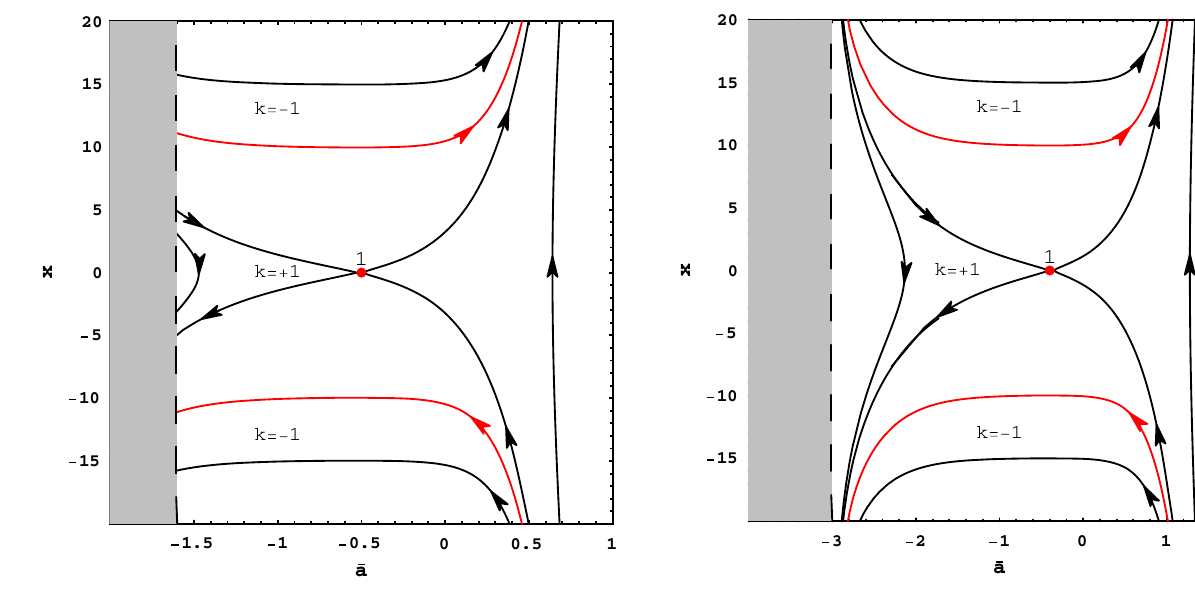
Fig. 12 The phase portrait for system (15)–(16) in the Einstein frame Fig. 11 The phase portrait for system (15)–(16) in the Einstein frame in the case when the evolution of the universe starts from the freeze inthecasewhentheevolutionoftheuniversestartsfromthegeneralized singularity. For illustration it is assumed that f ( ˆ R ) = ˆ R + γ ˆ R 2 + δ ˆ R 3 , suddensingularity.Forillustrationitisassumedthat f ( ˆ R ) = ˆ R + γ ˆ R 2 + (cid:3) (cid:4) (cid:3) (cid:4) (cid:3) (cid:4) (cid:3) (cid:4) s 2 Mpc 2 s 4 Mpc 4 s 2 Mpc 2 s 4 Mpc 4 δ ˆ R 3 , where γ = 10 − 9 where γ = − 10 − 9 and δ = − 10 − 13 .Criticalpoint and δ = 10 − 13 . Critical km 2 km 4 km 2 km 4 (1) represents the static Einstein universe and is a saddle. The black point (1) represents the static Einstein universe and is a saddle. The dashed line presents the freeze singularity. The gray color presents black dashed line presents the generalized sudden singularity. The gray the non-physical domain ( ¯ a < ¯ a s ). The red trajectories represent the color presents the non-physical domain ( ¯ a < ¯ a s ). The red trajectories path of evolution for the flat universe. These trajectories separate the represent the path of evolution for the flat universe. These trajectories domainwithnegativecurvature( k = − 1)fromthedomainwithpositive separate the domain with negative curvature ( k = − 1) from the domain curvature ( k = + 1). The scale factor is expressed in a logarithmic scale with positive curvature ( k = + 1). The scale factor is expressed in a